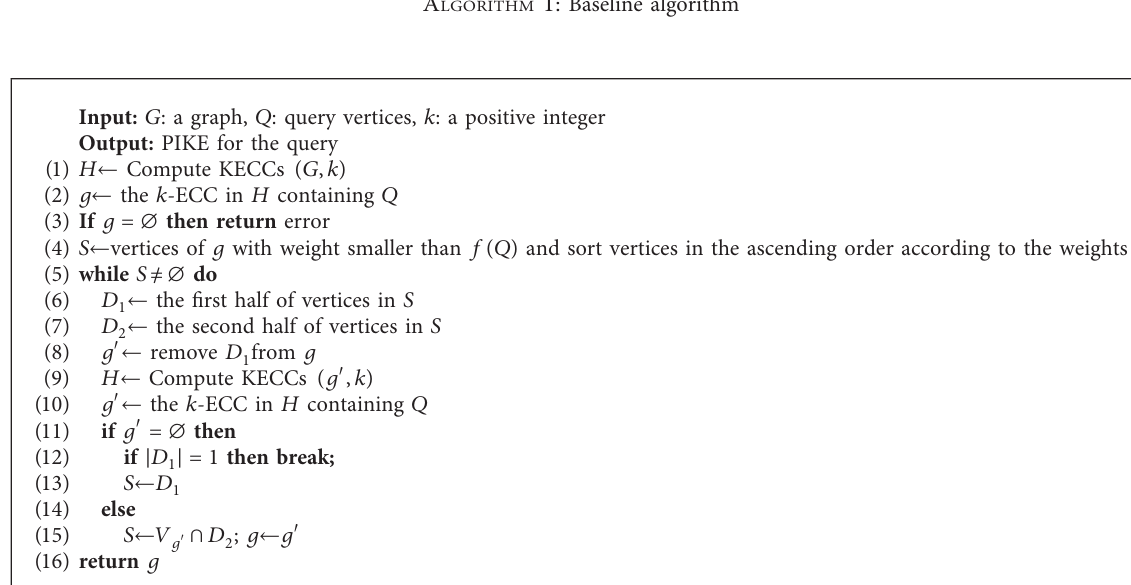
A LGORITHM 2: Dichotomy-based